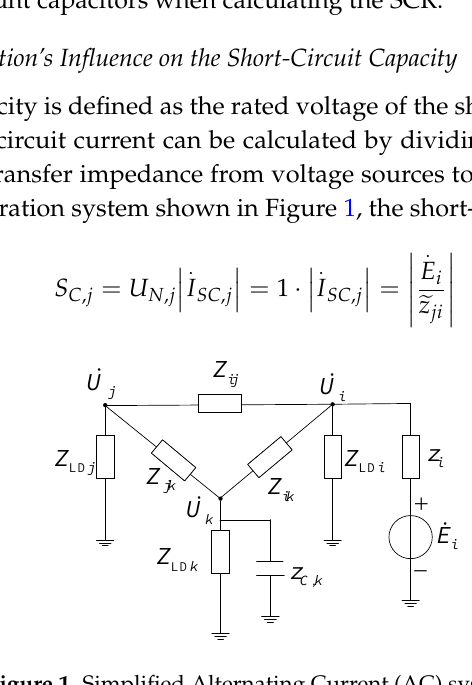
Figure 1. Simplified Alternating Current (AC) system.